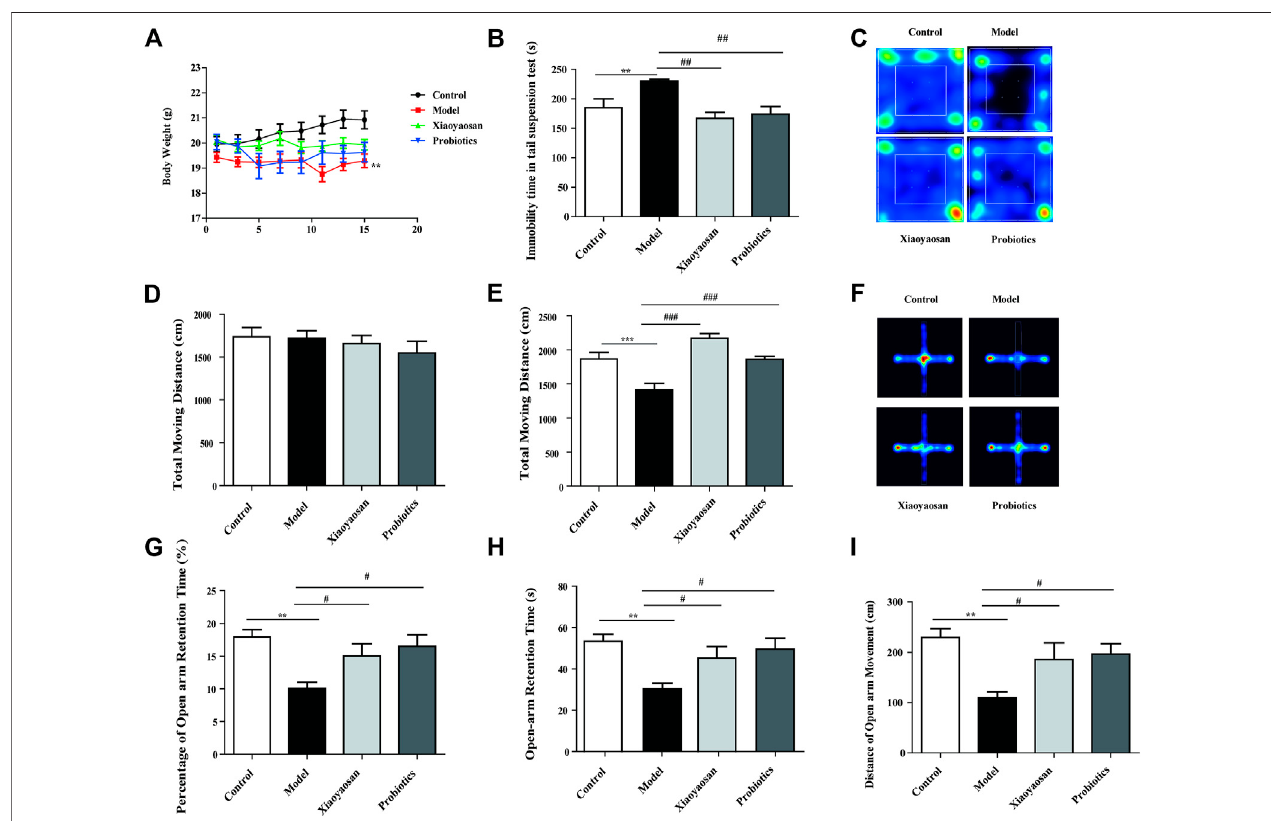
FIGURE2| Xiaoyaosanimprovesdepressive-likebehaviorandanxiety-likebehaviorinantibiotic-inducedmice. (A) Changesinbodyweight. (B) TST. (C) Heatmap ofOFT. (D) OFTonday0. (E) OFTonday14. (F) HeatmapofFPM. (G,H,I) EPM.Dataareexpressedasthemean ± SEM.** p < 0.01,*** p < 0.001vs.thecontrolgroup; # p < 0.05, ## p < 0.01, ### p < 0.001 vs. the antibiotic-induced model group. n (cid:2) 10 per